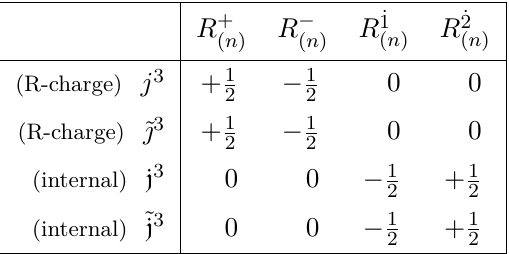
Table 1 . SU(2) charges of Ramond